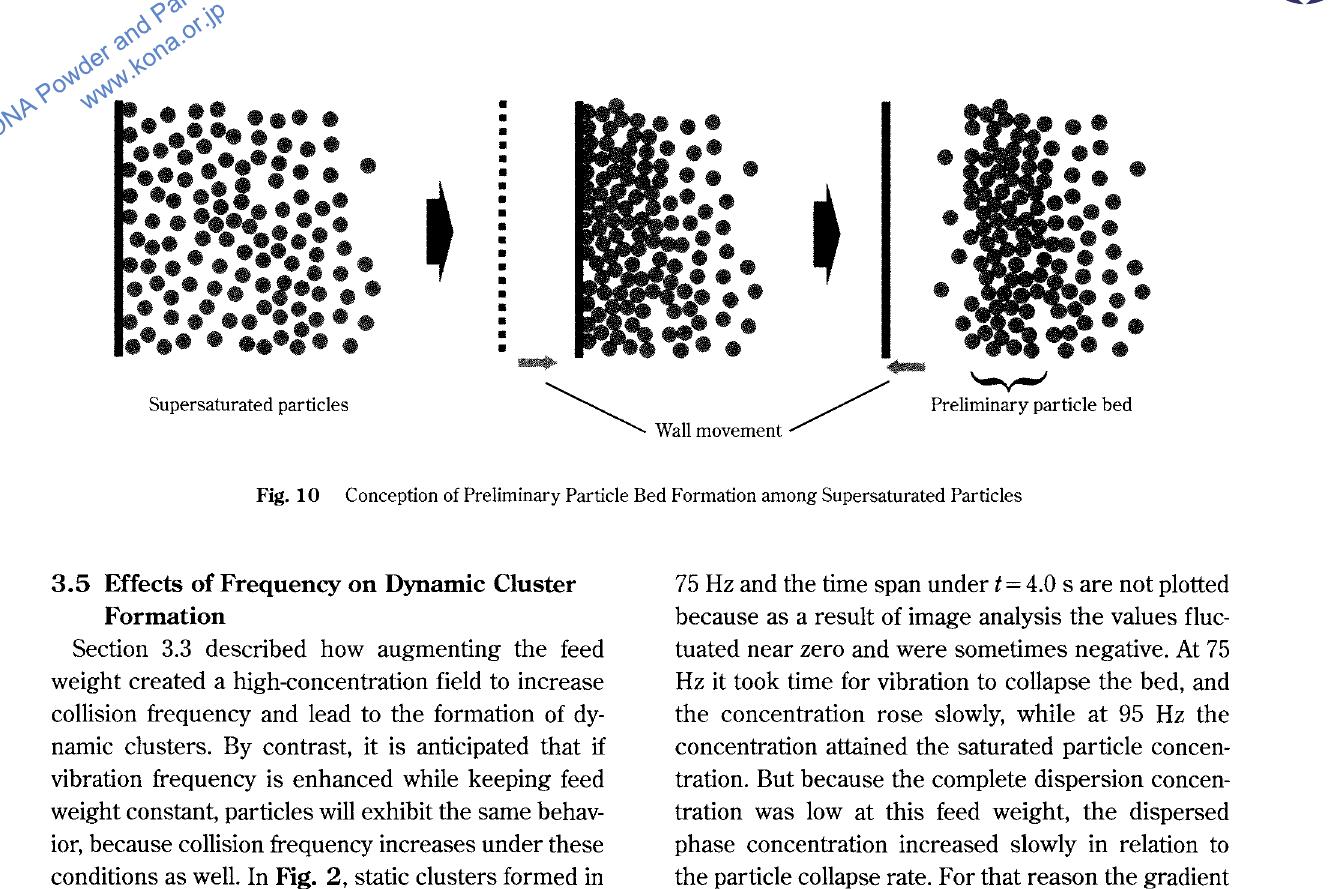
Fig. 11 Particle Behavior at High Frequency Ad= 300 ~J.m,/= 95 Hz and M = 3 g